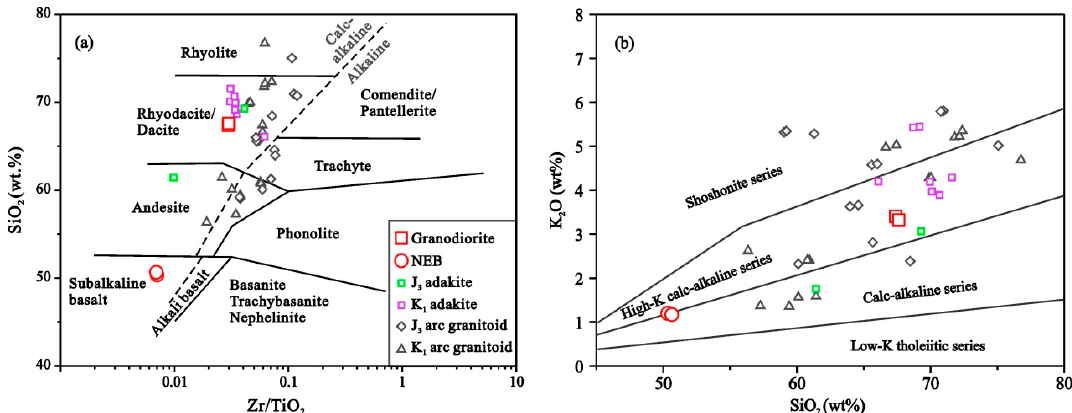
Figure 6. Classification diagrams of SiO 2 versus Zr/TiO 2 ( a ) and K 2 O versus SiO 2 ( b ) for the granodiorite and NEB samples obtained from the Xiaozhenzhu Seamount near the Zhongnan Fault in the South China Sea (SCS). The compositions of the Late Jurassic (J 3 ) adakites and arc granitoids and of the Early Cretaceous (K 1 ) adakites and arc granitoids from the SCS [23,24] are also shown. The granodiorites have low total REE concentrations (84.7–91.6 μ g/g). Chondrite ‐ normalized REE patterns (Figure 7a) show negligible to weak negative Eu anomalies ( δ Eu = 0.88–0.93) and are enriched in LREEs and depleted in HREEs with high (La/Yb) N ratios (13.8–15.7). Their low